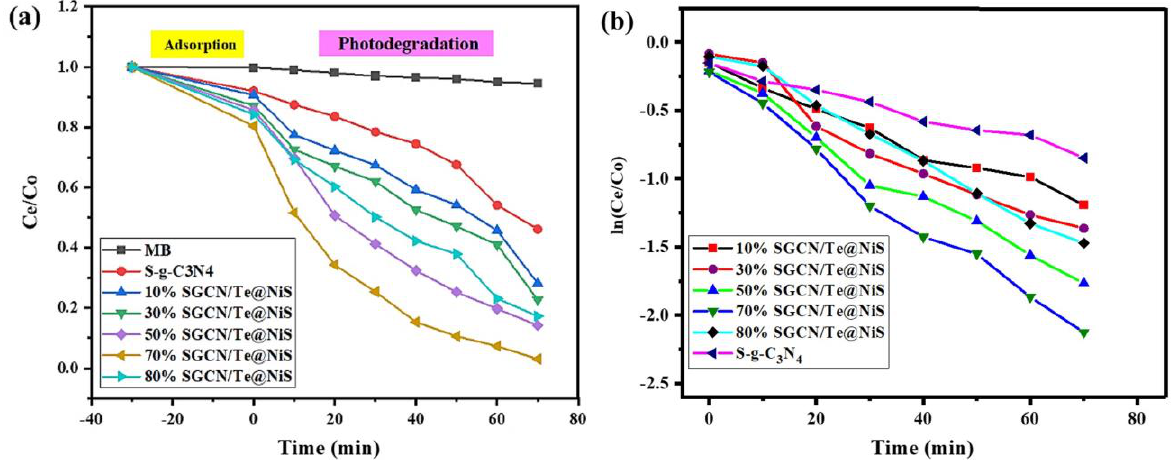
Figure 8. Degradation efficiency ( a ). Kinetic study of photocatalytic degradation of MB by SGCN/Te@NiS NCs ( b ). Table 1. Photocatalytic efficiency of the SGCN/Te@NiS NCs and some previously reported work.